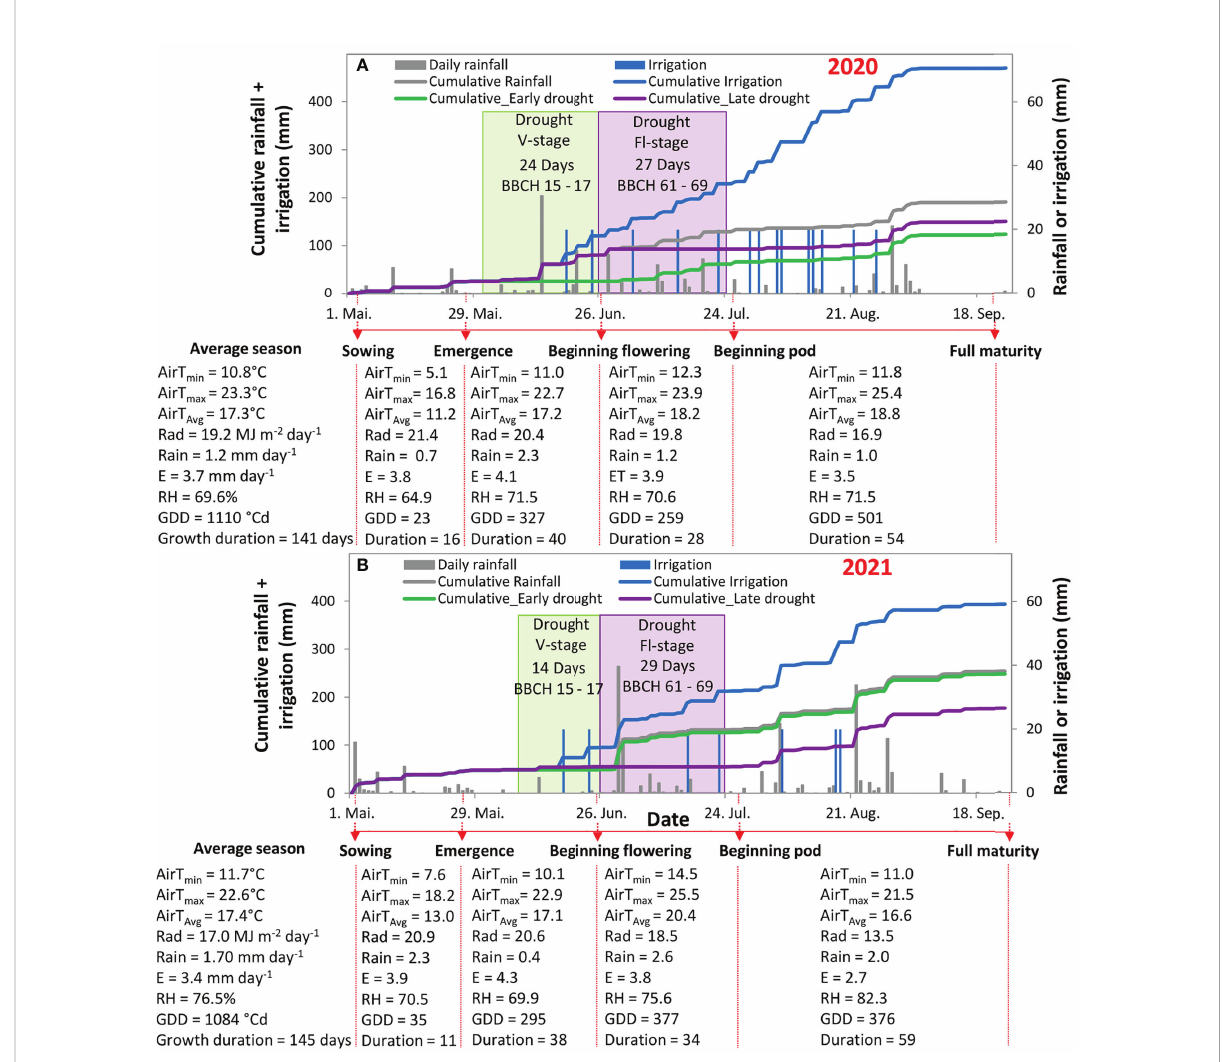
FIGURE 1 Cumulative water input (rainfall + irrigation; left axis; A, B ) and daily rainfall or irrigation (right axis; both panels) from the beginning of May till the end of September in the season 2020 (A) and 2021 (B) . The green shaded area indicates the duration of using a shelter above the plants at the vegetative stage (V-stage) and the violet shaded area indicates the duration of using a shelter above the plants at the fl owering stage (Fl- stage). The Meteorological elements and bioclimatic index for the soybean development stages, in both years, are in the tables below each fi gure specifying, in each phenological period, the minimum temperature (T min ), the maximum temperature(T max ), the average temperature (T Avg ), the average solar radiation (Rad), the average rainfall (Rain), the daily evaporation (E), the percentage of relative humidity (RH), and the growing degree days